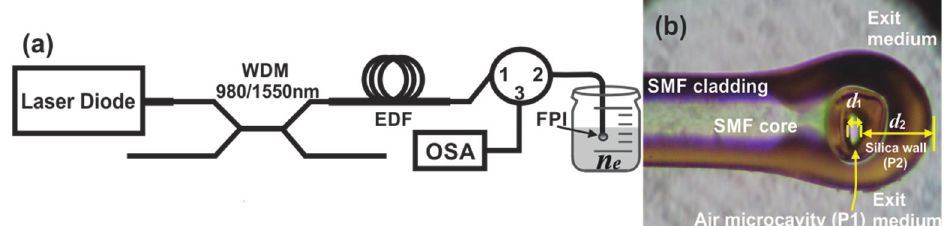
Figure 2. ( a ) Setup used to characterize the micro FPI spectral response as a function of the exit medium refractive index; ( b ) Picture of the fabricated FPI.